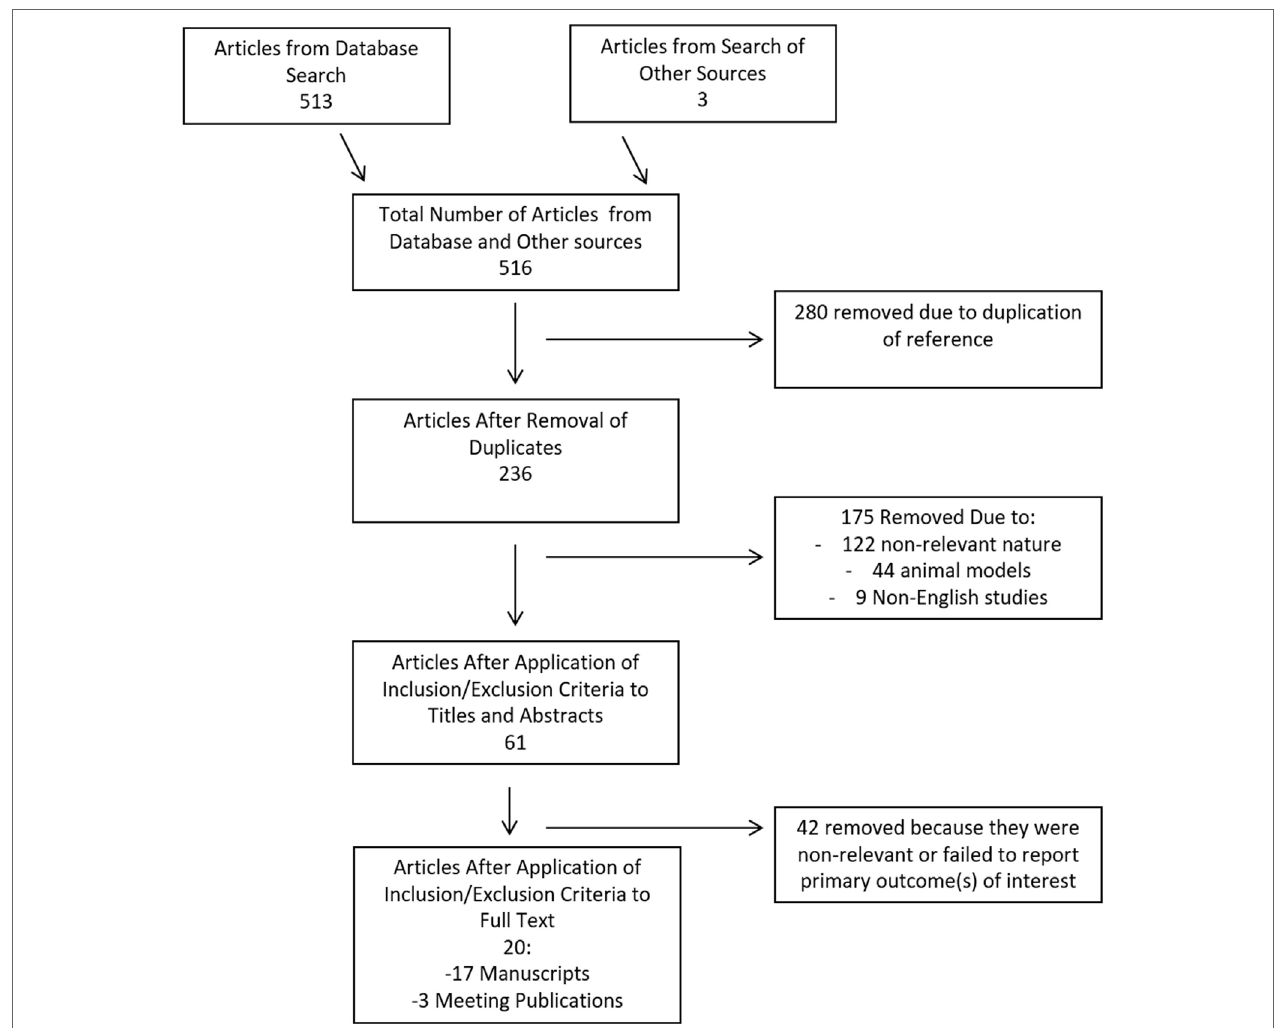
FiGURe 2 | Flow diagram of search results for cerebrospinal fluid